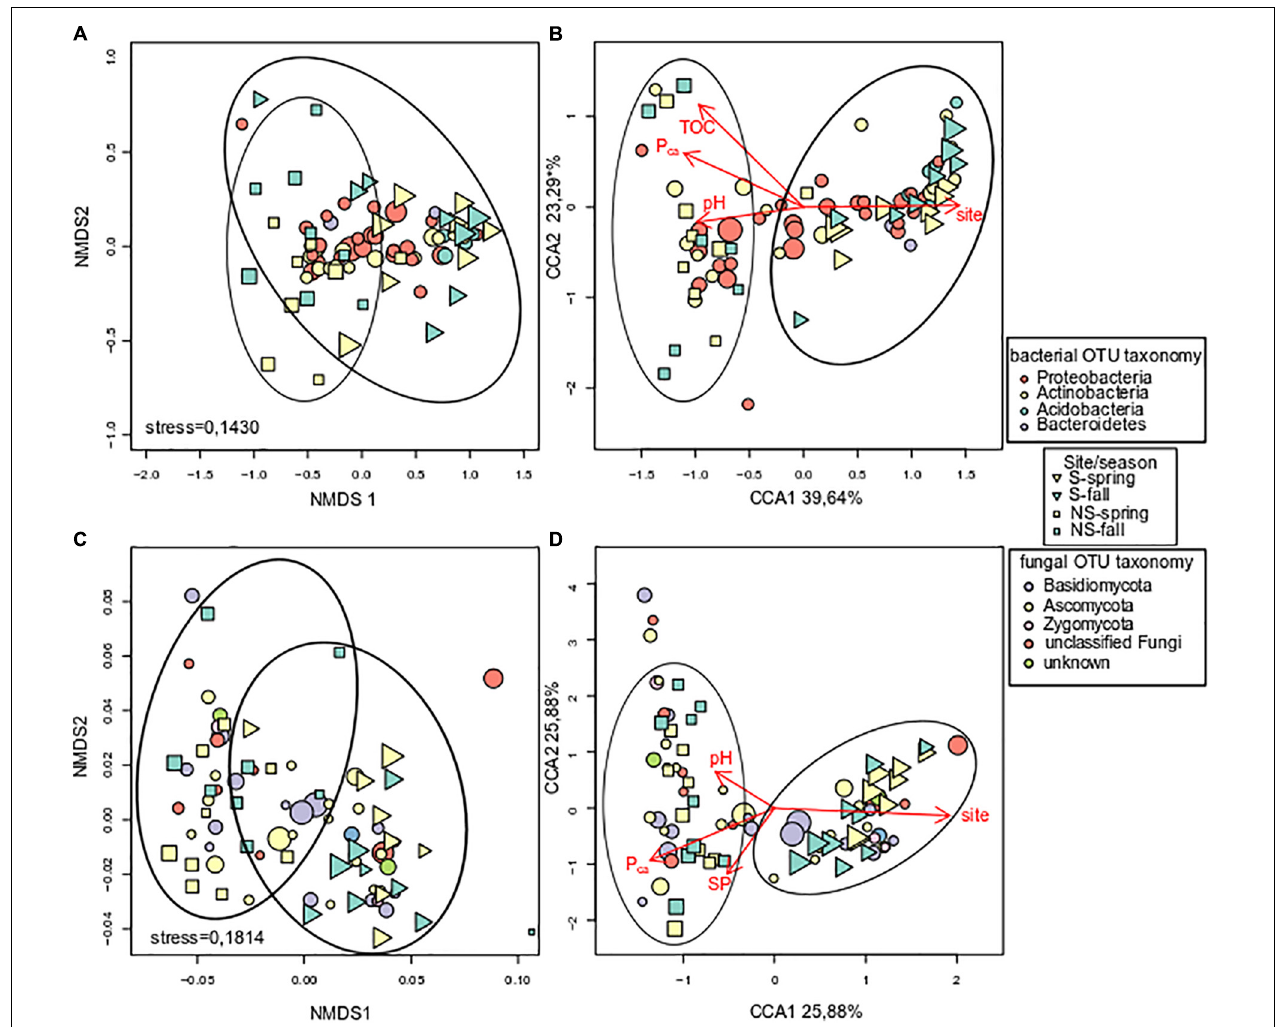
FIGURE 4 | Analysis of log-transformed and Wisconsin double-standardized Bray–Curtis dissimilarity matrix for bacterial and fungal communities, respectively: (A) stress = 0.1430 and (C) stress = 0.1814 – NMDS (non-metric multidimensional scaling analysis), (B,D) – CCA (canonical correspondence analysis). Circles represent OTUs, their fill color denotes consensus taxonomy at the phylum level. Fifty most abundant OTUs were plotted in each case. Squares and triangles represent sites, their fill color means season. Area of figures is proportional to square root of EC e (electrical conductivity) in soil